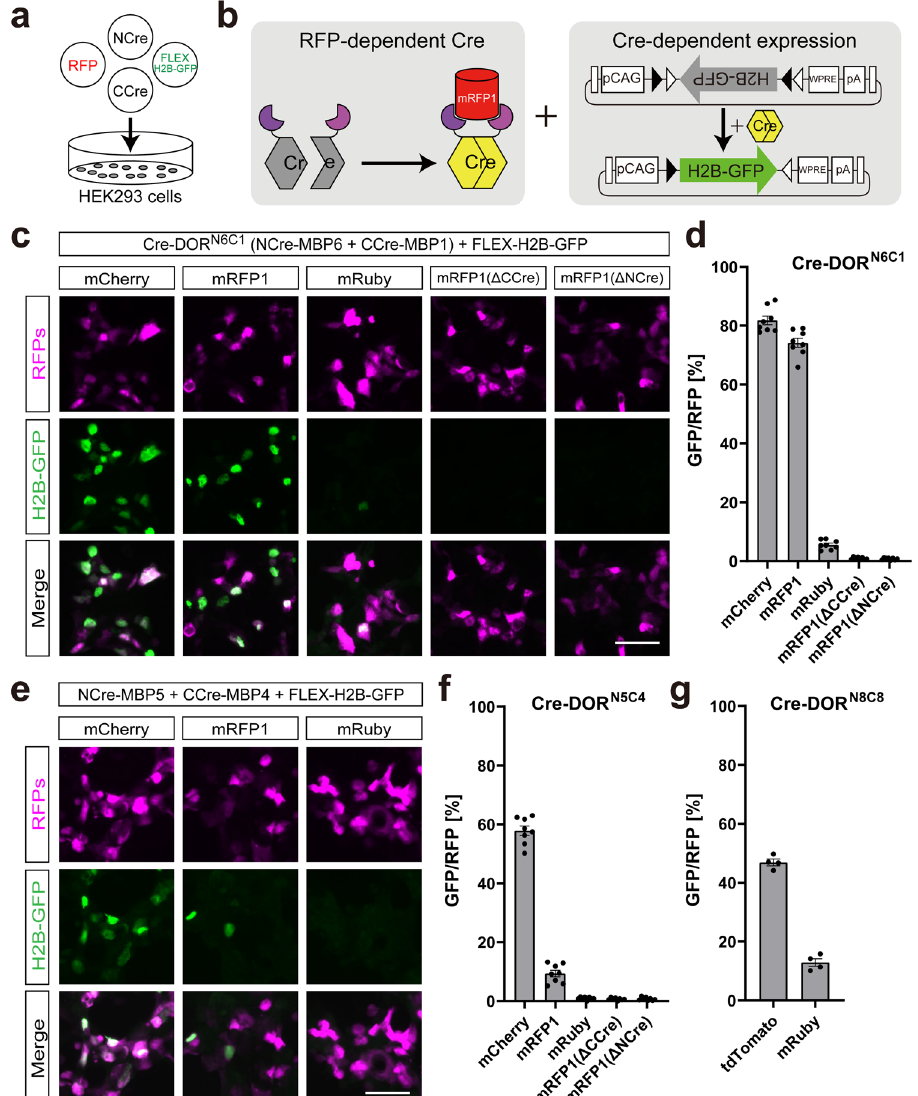
Fig. 2 Functional assay of Cre-DOR in HEK293 cells. a Schematic illustration of Cre-DOR transfection in HEK293 cells. Four kinds of plasmids (NCre-MBP, CCre-MBP, FLEX-H2B-GFP, and target RFPs) were transfected in HEK293 cells to assess Cre-DOR recombination ef fi ciency. b Illustration of speci fi c expression of H2B-GFP induced by Cre-DOR activated by mRFP1. c Fluorescent images of reporter H2B-GFP expression in transfected HEK293 cells to assess Cre-DOR (N-Cre-MBP6 and C-Cre-MBP1) ef fi ciency for target RFPs. d Quanti fi cation of cell counts in transfected HEK293 cells to assess Cre-DOR (N-Cre-MBP6 and C-Cre-MBP1) ef fi ciency for all components of the system. e Fluorescent images of reporter H2B-GFP expression in transfected HEK293 cells to assess Cre-DOR (N-Cre-MBP5 and C-Cre-MBP4) ef fi ciency for target RFPs. f , g Quanti fi cation of cell counts in transfected HEK293 cells to assess Cre-DOR (N-Cre-MBP5 and C-Cre-MBP4) ef fi ciency for all components of the system. Data are means± SEM ( n = 8 or n = 4 in g ). Scale bar = 50 μ